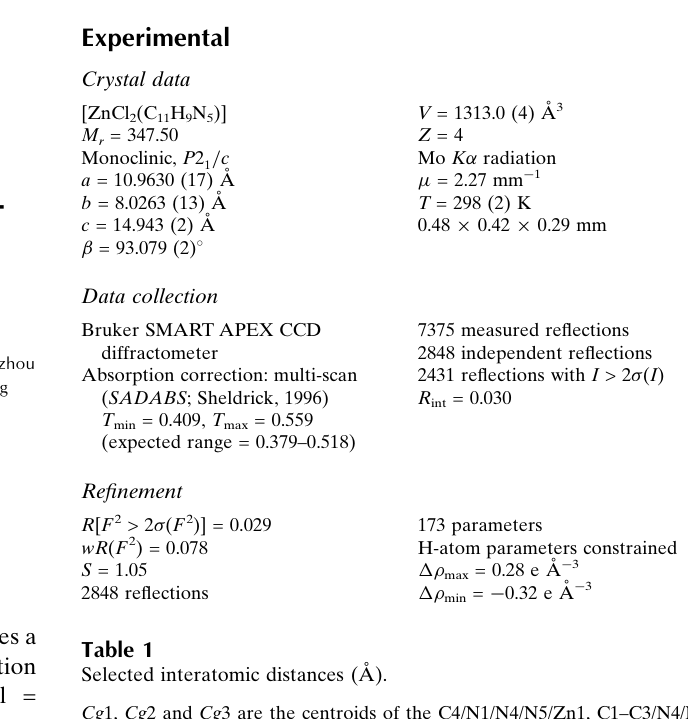
Selected interatomic distances (A˚